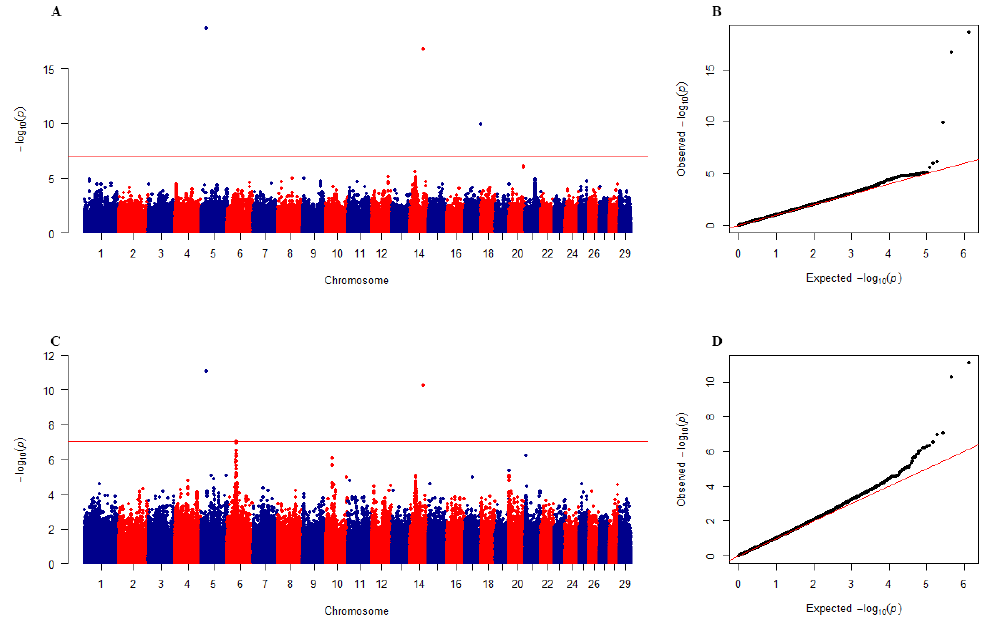
Figure 3. Manhattan and quantile-quantile (QQ) plots of genome-wide association studies for CW and BW in the Chinese Simmental beef cattle population. ( A , B ) are Manhattan and QQ plots for CW; ( C , D ) are Manhattan and QQ plots for BW.